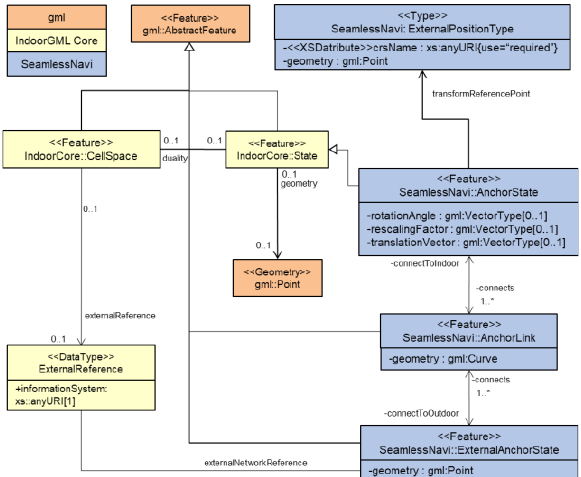
Figure 3 . UML Diagram of the SeamlessNavigation Module (OGC (Open Geospatial Consortium), 2019)